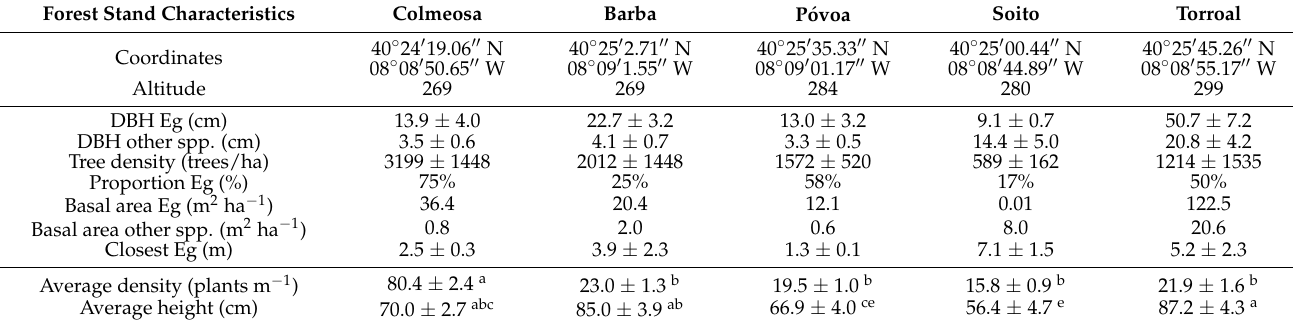
Table 1. Characterisation of forest stands. DBH: Diameter at breast height (mean ± SE) of Eucalyptus globulus (Eg) and other tree species (other spp.); Proportion Eg: the proportion of E. globulus trees in the stand; Closest Eg: distance from transect to the closest E. globulus tree. Average density/average height: initial characteristics of the E. globulus wildling population. Uppercase letters show the result of multiple comparisons among forest stands using a post-hoc Nemenyi test. Different letters correspond to statistically significant differences ( p <